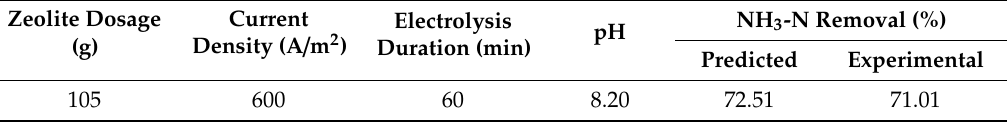
Table 6. Optimization between predicted and experimental results on NH 3 -N